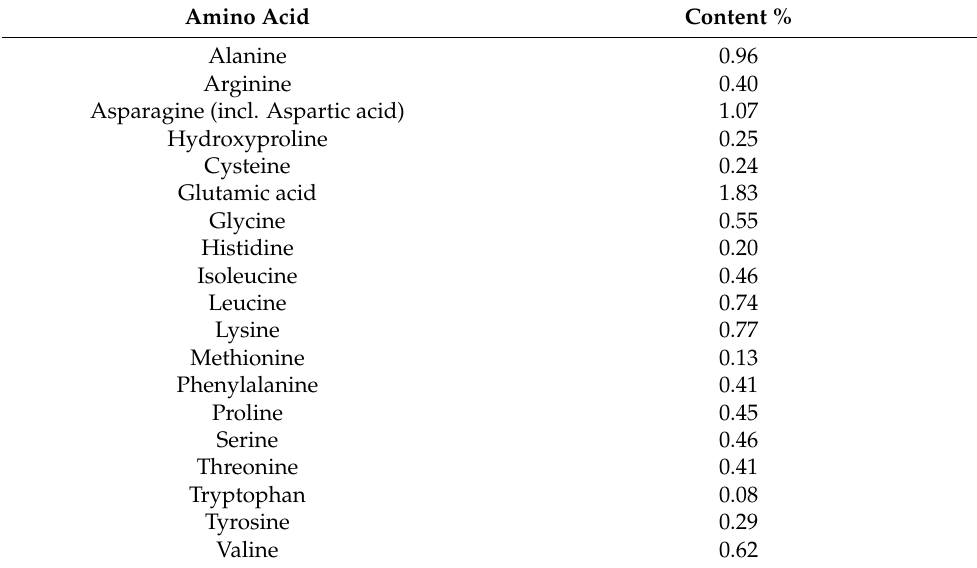
Table 1. Eluate amino acidic composition determined with HPLC